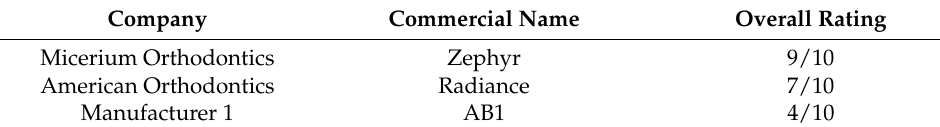
Table 7. Overall rating of the aesthetic brackets.